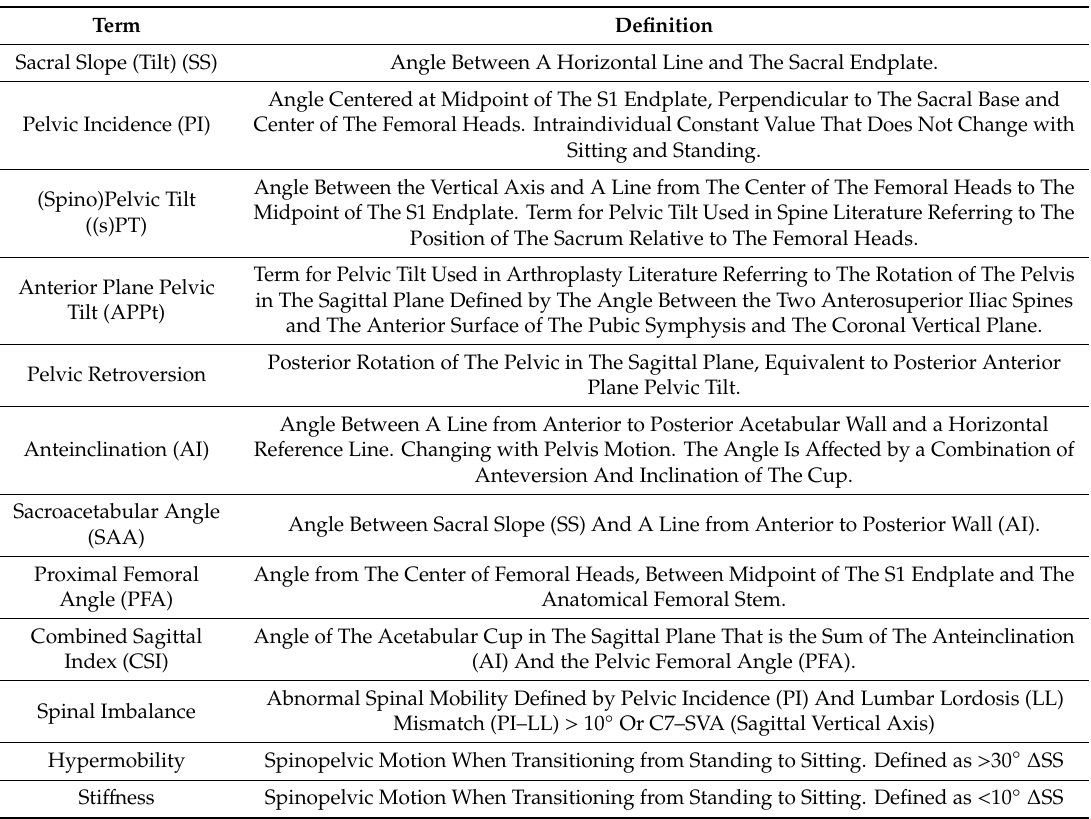
Table 1. Overview of terms related to spinopelvic mobility according to Ike et al., Attenello et al., and Lum et al.